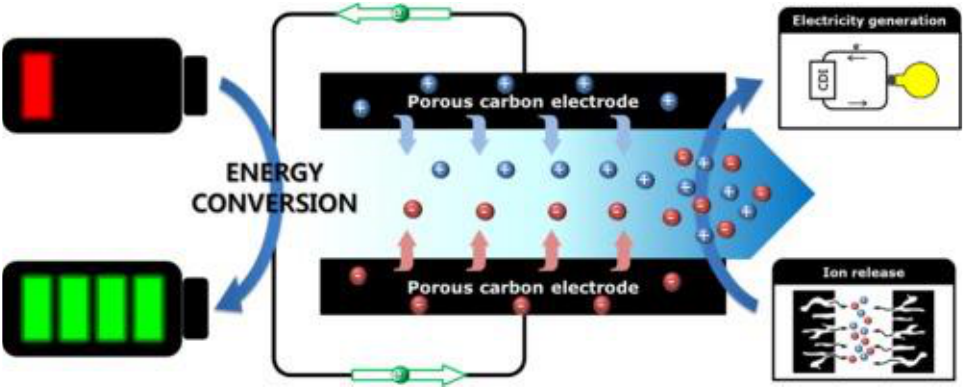
Figure 6. An example of energy recovery of CDI. Reproduced with permission from [103]. Copyright 2016 Elsevier.